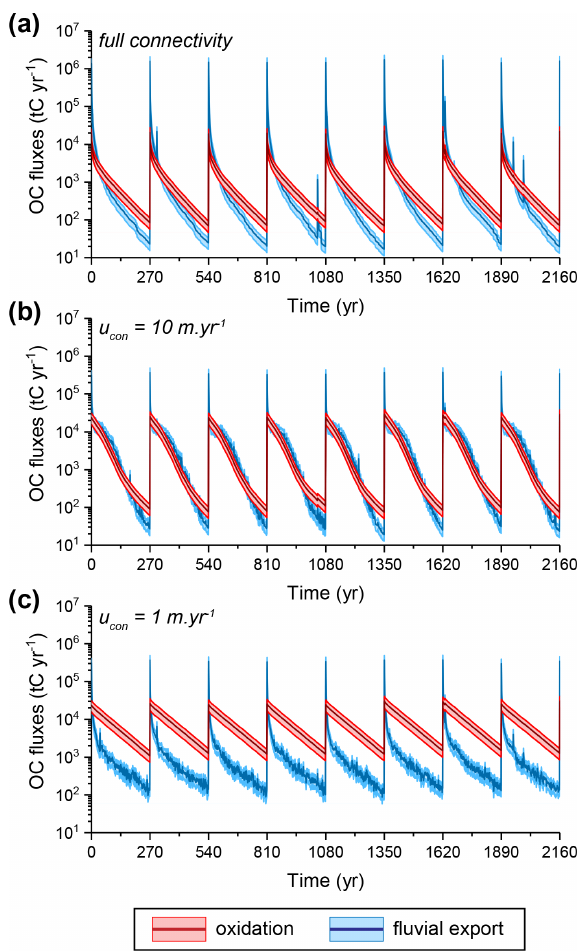
Figure 10. The modeled fate of landslide-mobilized OC over sev- eral seismic cycles based on parameters set by the Alpine Fault, western Southern Alps, New Zealand, with the single pool model and k ox = 1%yr − 1 . Each panel shows the fluxes of OC exported by rivers (in blue) and the release of CO 2 to the atmosphere from OC oxidation (in red) for different connection velocity scenarios: (a) full connectivity, (b) u con = 10myr − 1 , (c) u con = 1myr − 1 . The envelope for each plot accounts for the uncertainties in the soil OC